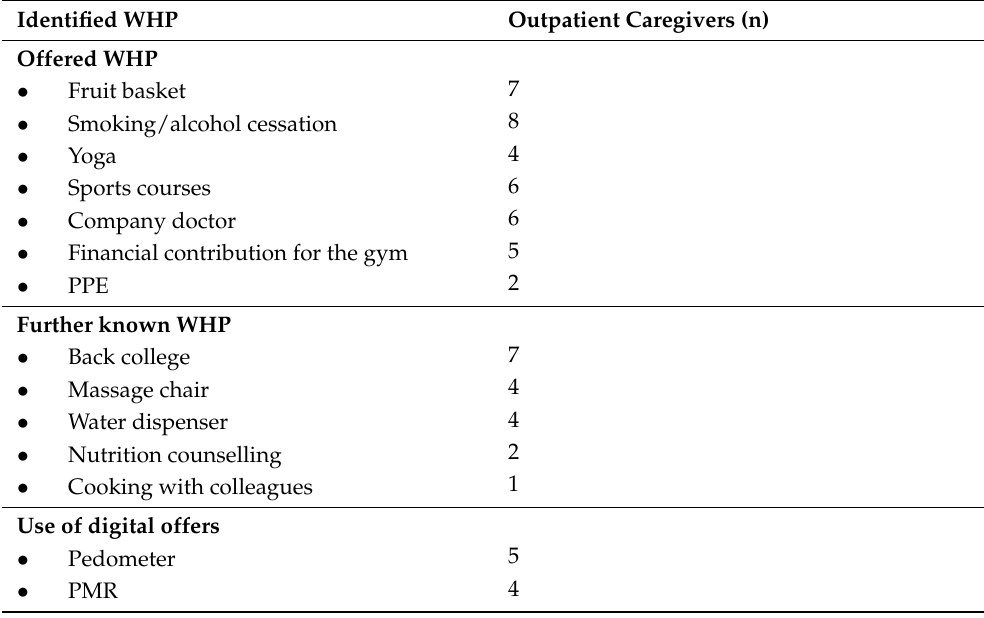
Table 3. Identified WHP among interviewed outpatient